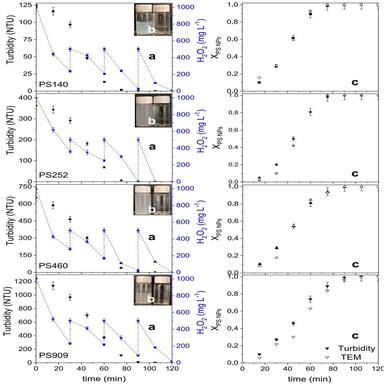
Photo-Fenton oxidation of PS NPs of different particle sizes: a) turbidity and hydrogen peroxide evolution, b) Visual inspection of the reaction volume without treatment and at final reaction time, and c) PS NPs conversion determined from turbidity (black markers) and TEM (white markers) measurements (D0 = 140, 252, 460 and 909 nm; 0 = 100 mg/L; 0 = 1 mg/L; 0 = 1000 mg/L (H2O2 dosed every 30 min, 500 mg/L); pH0 = 3; T = 25 ◦C).